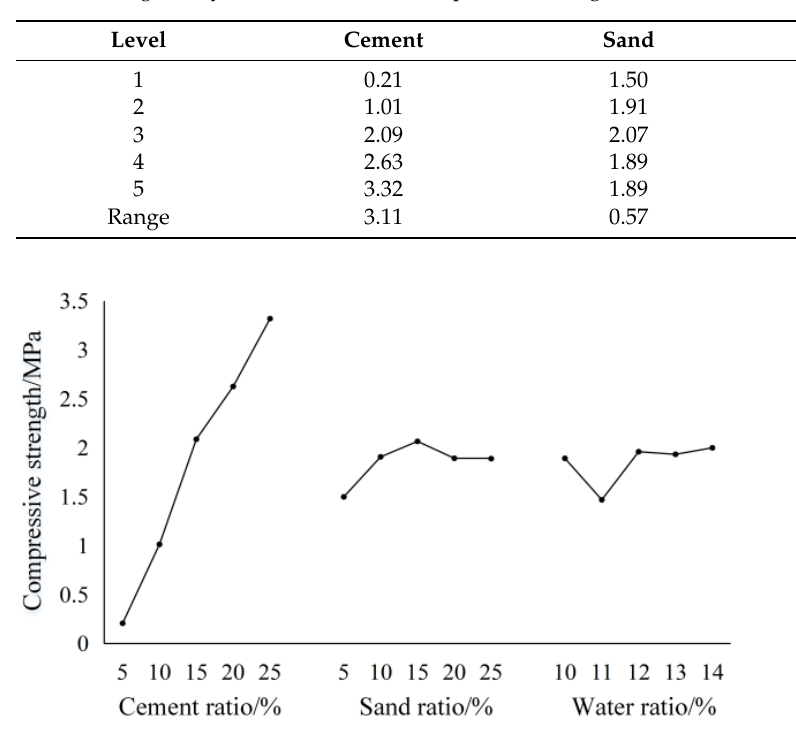
Figure 8. Trend chart of influencing factors of compressive strength.